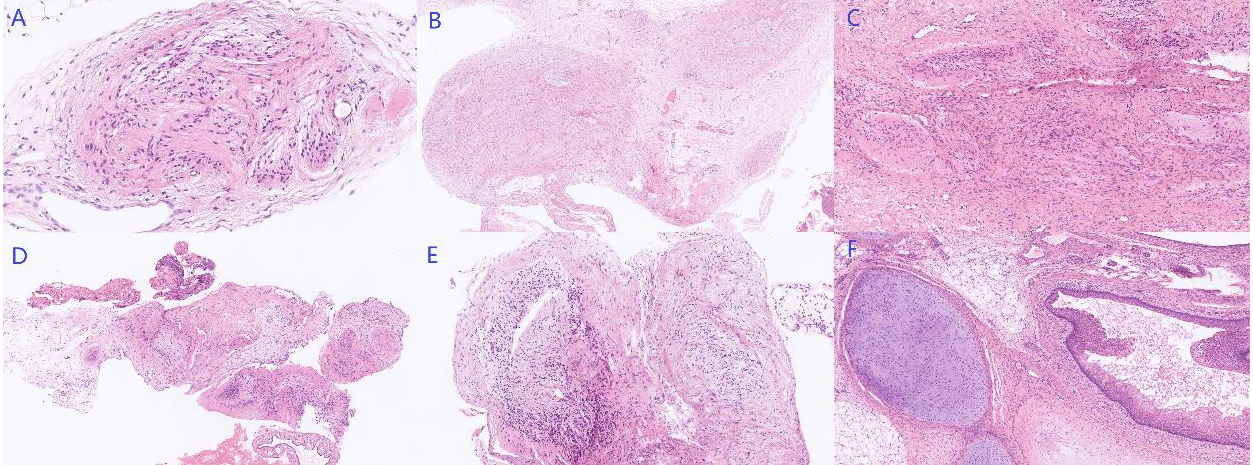
Figure 6. Pathology results of peritoneal seeding of GP and GTS (HE staining). Mature neuroglia presented with distinctive rounded, or ovoid nodules with well-defined boundaries involving omentum majus ( A , 200×), vesical peritoneal reflection ( B , 25×), peritoneum of ascending colon ( C , 50×), right ovarian cyst ( D , 50×), and posterior uterine wall ( E , 50×), while mature cartilage and squamous epithelium differentiation were observed in the mass ( F , 50×).